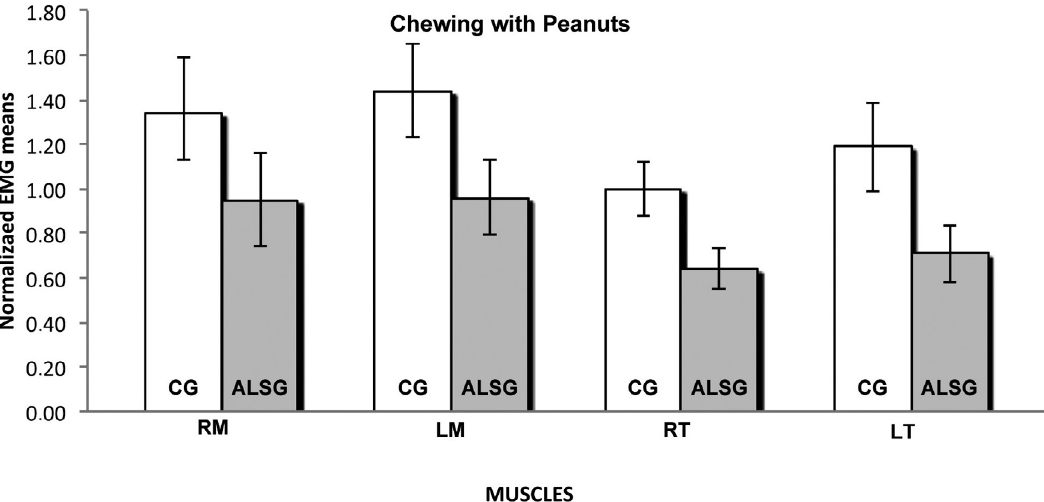
Figure 6- Normalized electromyography data of masseter (RM: right masseter; LM: left masseter) and temporalis (RT: right temporal; LT: left temporal) muscles for CG and ALSG in the chewing with peanuts